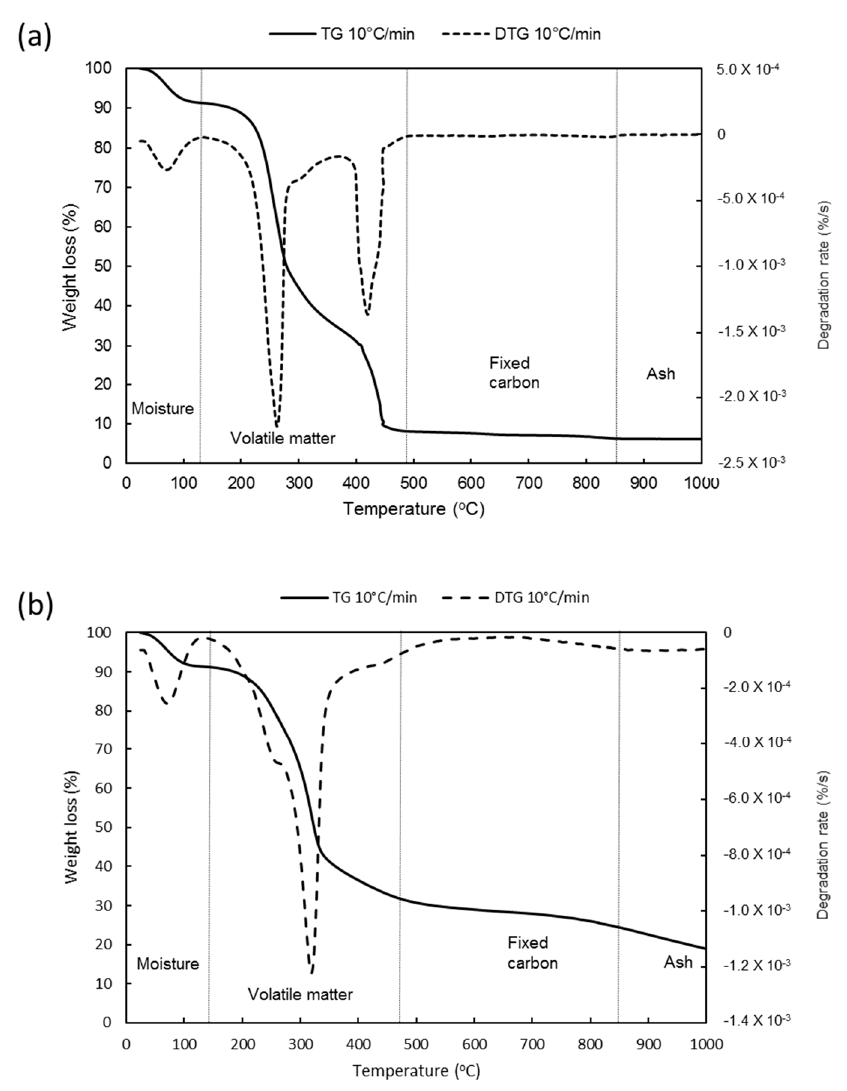
Figure 2. Proximate analysis of Napier grass in ( a ) air and ( b ) nitrogen at a constant flowrate of 25 mL/min.